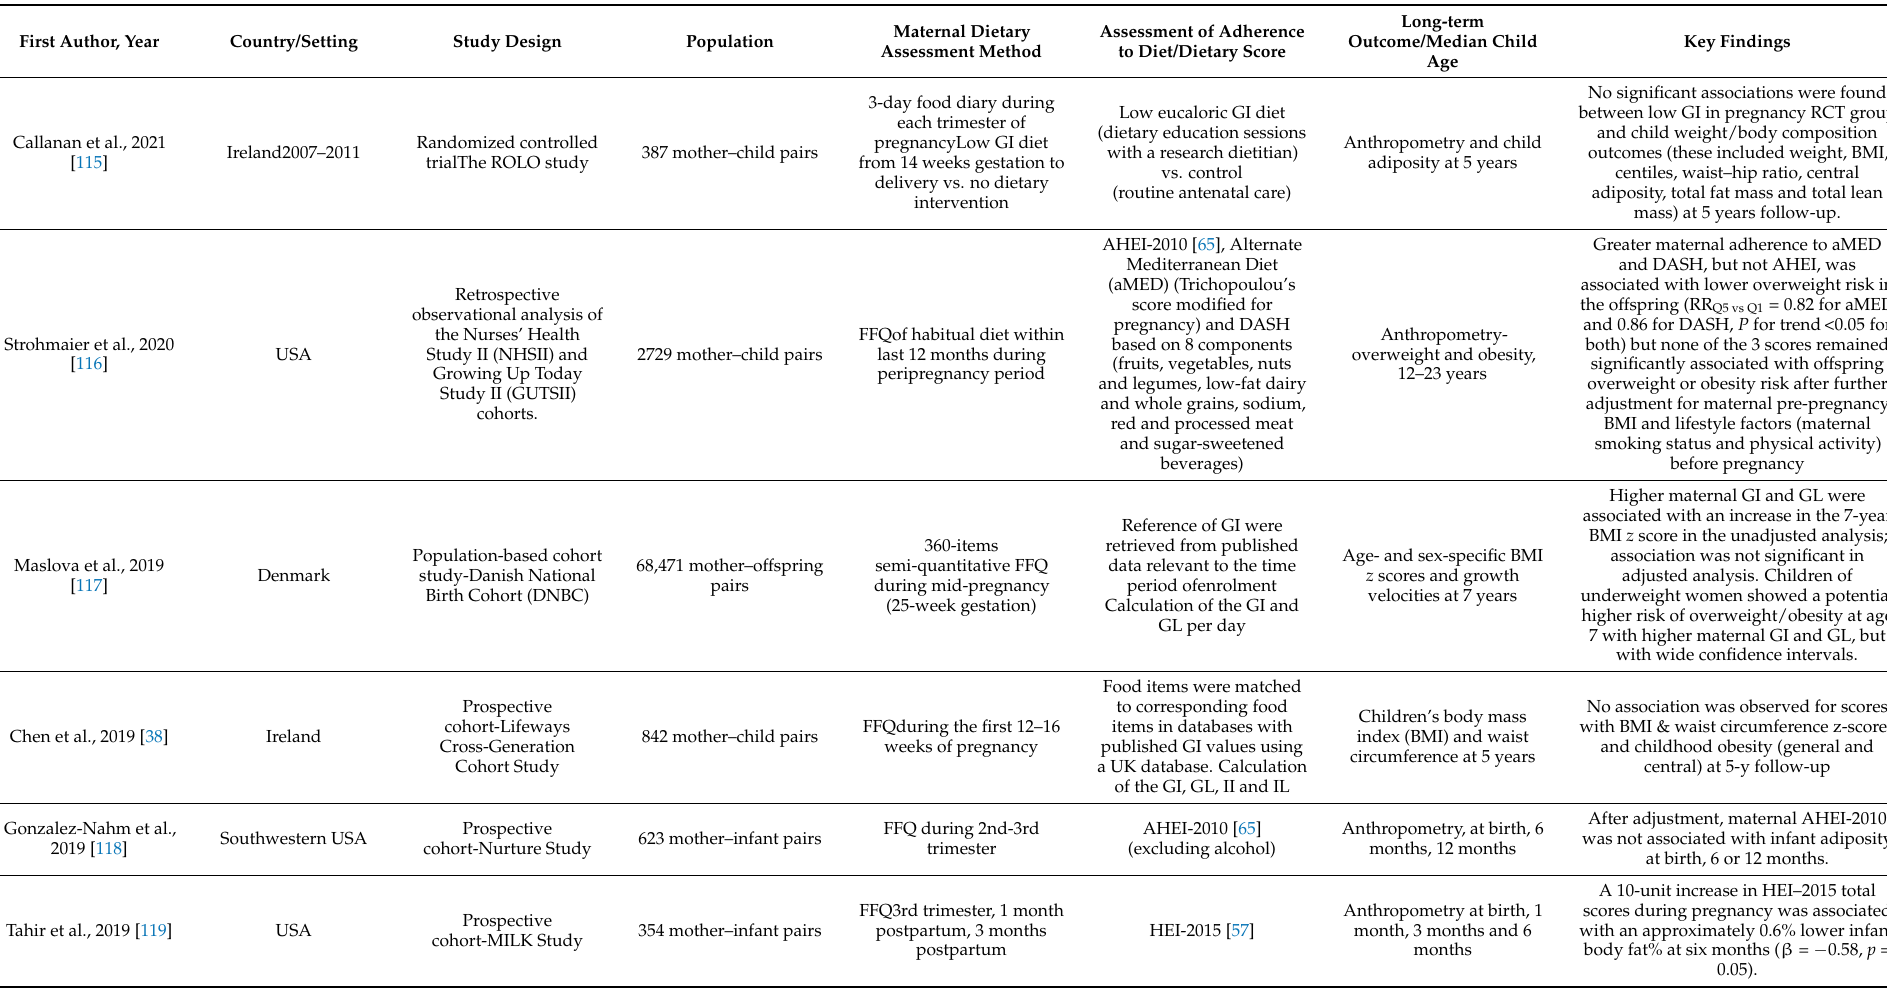
Table 7. Studies investigating maternal dietary scores and long-term offspring